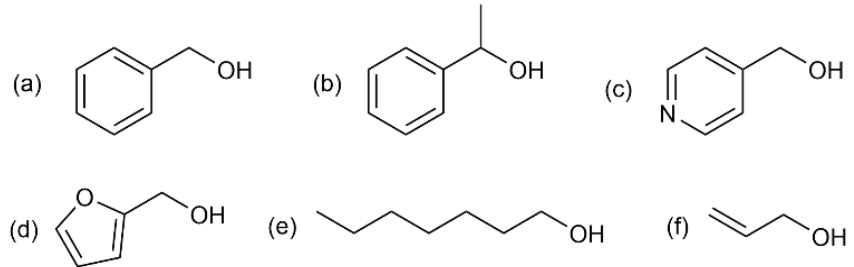
Figure 3. Structures of six representative alcohols: benzyl alcohol ( a ), 1-phenylethanol ( b ), 4-pyridinemethanol ( c ), furfuryl alcohol ( d ), n-heptanol ( e ) and allylic alcohol ( f ), used in the catalytic studies.